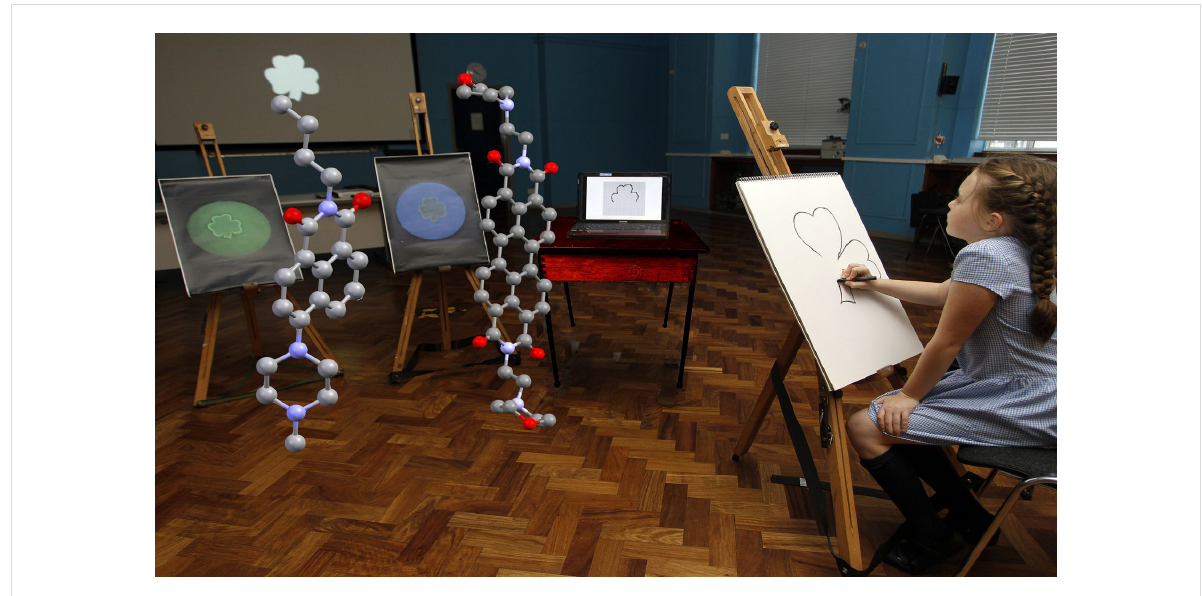
Figure 8: Comparison of how a child, a computer and the molecules 7 and 9 draw the outline of a shamrock object on the wall screen. Photograph used by permission of Karen-Louise Daly, Brian Daly and Aodhan O’Raghallaigh.